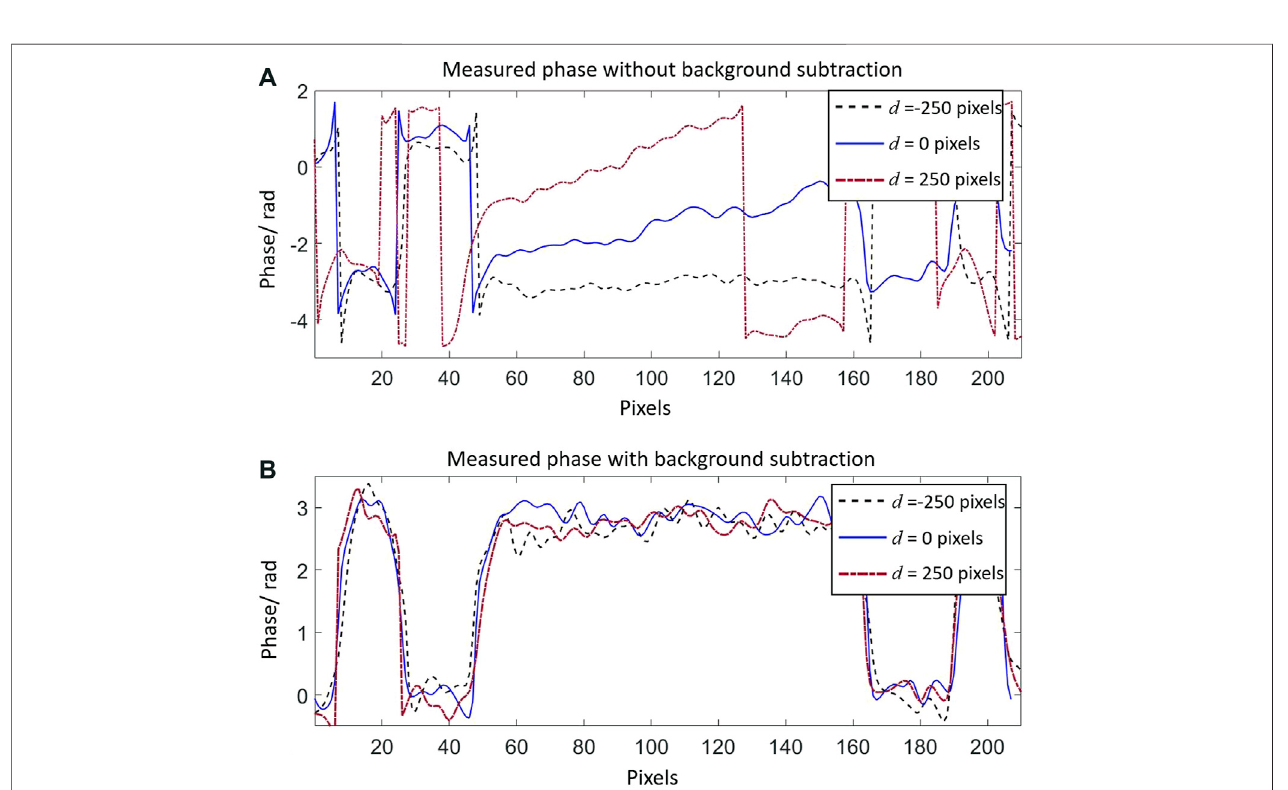
FIGURE 9 | (A) Measured phase along the line of the object without background subtraction. (B) Measured phase along the line with background subtraction.